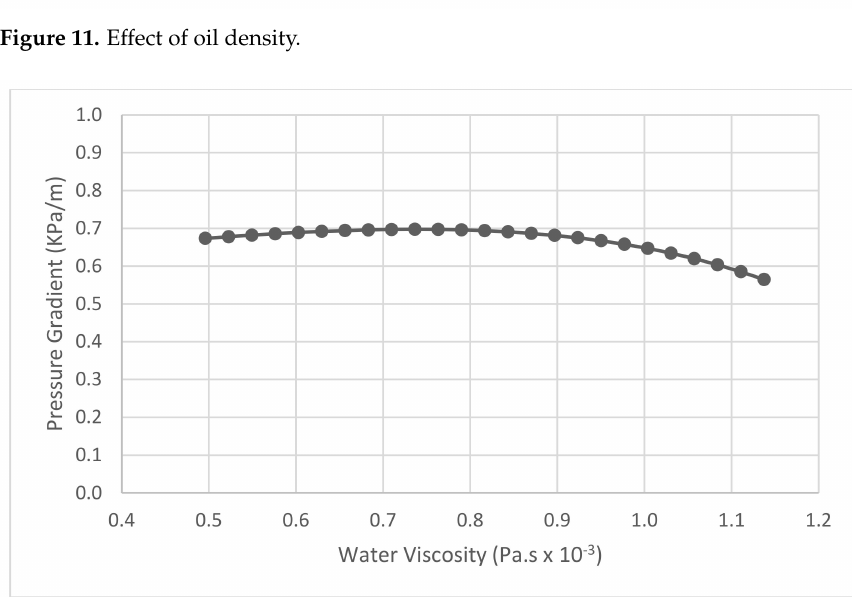
Figure 12. Effect of water